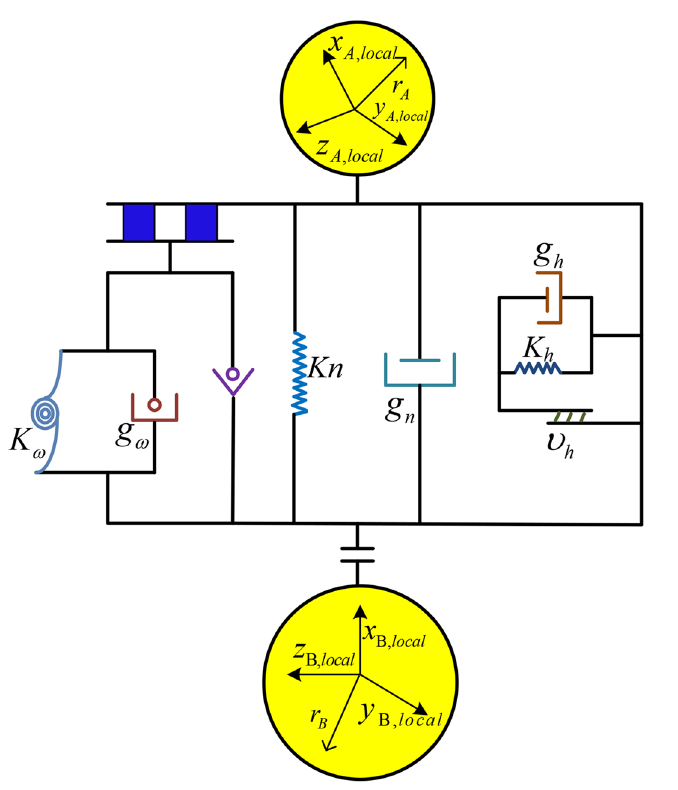
Figure 5. Particles contact